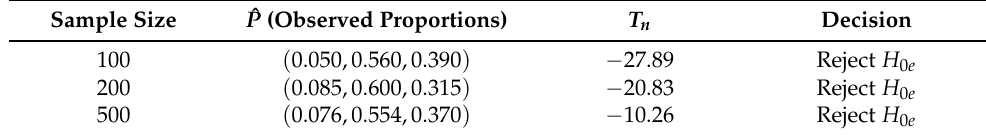
Table 9. Application of the equivalence test to classification of slopes: Case #1.